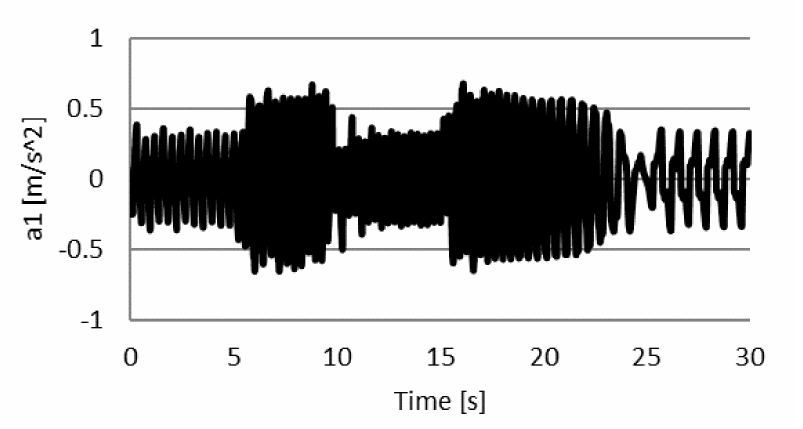
Figure 17. Change in the wheels’ pressure on the road surface on the front axle with control by criterial function K sky .